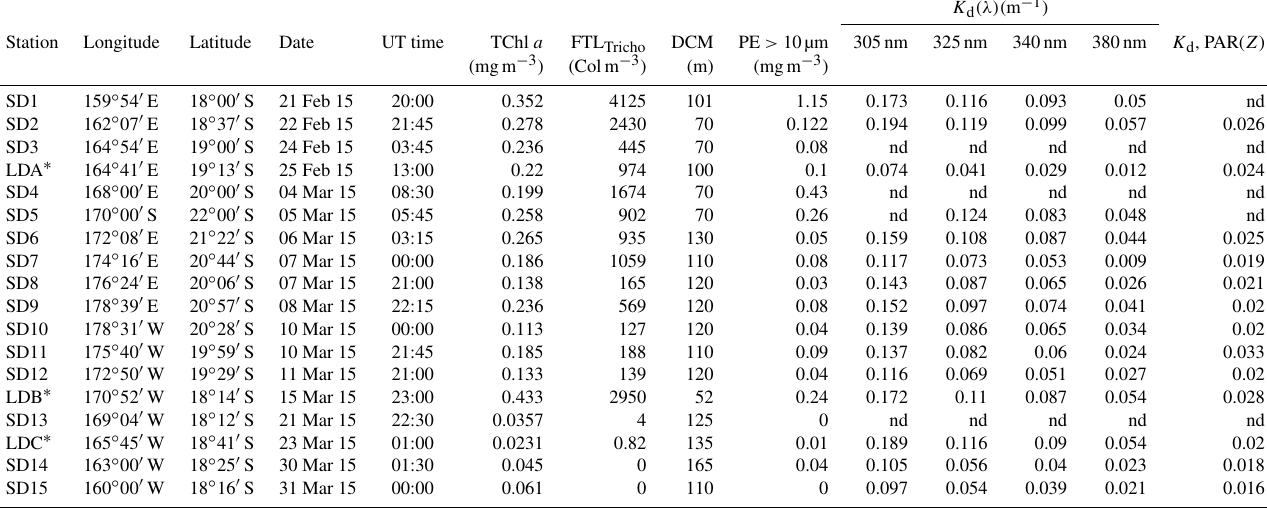
Table 1. Main characteristics of the OUTPACE stations for the TChl a concentration, PE > 10µm, FTL Tricho and attenuation coefficients from the free-fall Satlantic UV radiometer. TChl a : average concentrations in total chlorophyll a (monovinyl Chl a + divinyl Chl a ) in surface waters derived from HPLC analyses, based on duplicate analyses (CV < 8%). FTL Tricho abundance: determined using underwater vision profiler 5 (UVP5). DCM: deep chlorophyll maximum. PE > 10µm: phycoerythrin > 10µm. K d : diffuse attenuation coefficient for downward irradiance in the UV (305, 325, 340, 380nm) and PAR (400–700nm) domains. * Values for long-duration stations, i.e., LDA, LDB and LDC, averaged over 7 days. nd: could not be determined (night station). K d (λ)( m − 1